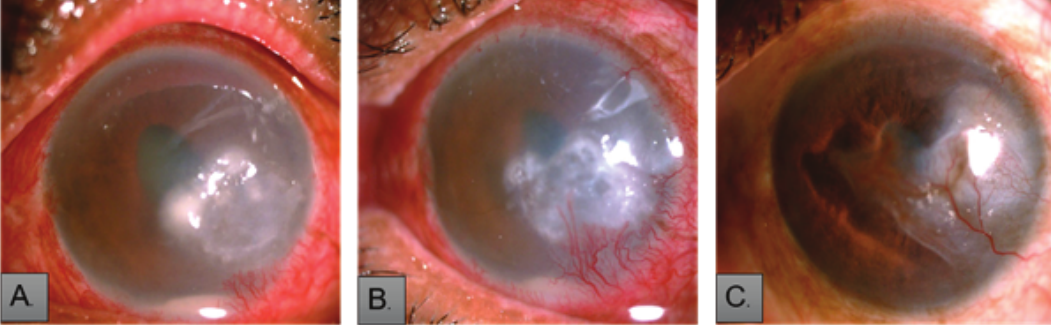
Figure 2. Slit-lamp image of case no. 4 which was treated as fungal corneal ulcer elsewhere came positive on corneal scraping (Ziehl Neelsen stain) after repeating twice (A) at presentation; (B) 15 days posttreatment with topical fortified amikacin (2.5%) and oral clarithromycin; and (C) after two months, scarred infiltrate with corneal